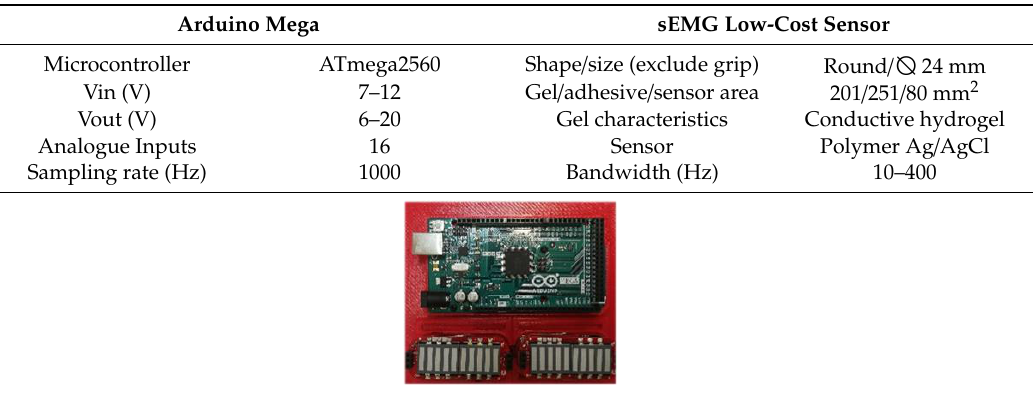
Table 1. Technical information of the sEMG device.